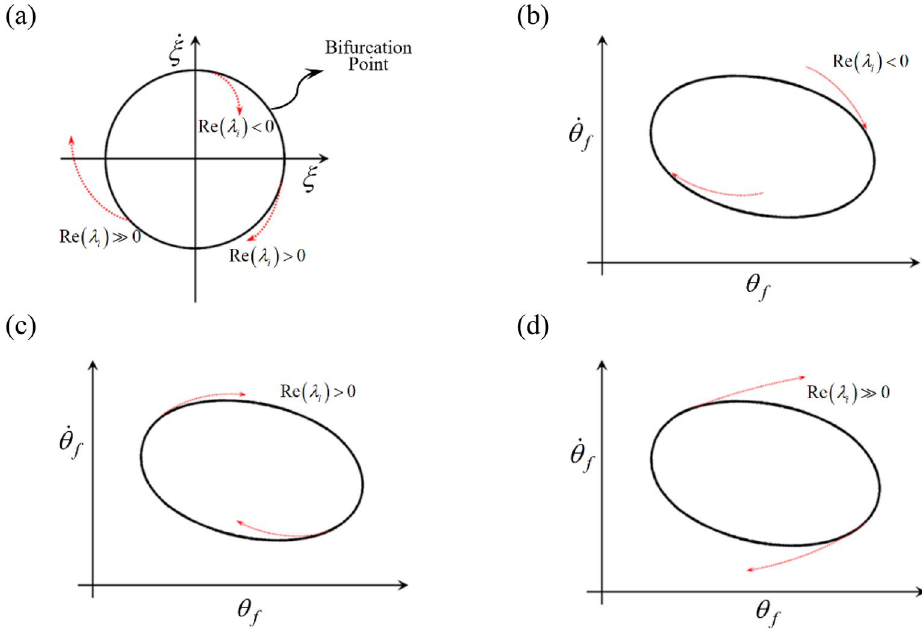
Figure 8. Nonlinear dynamic behaviors along with the various real parts of eigenvalues: ( a ) bifurcation points and various branches of transient responses; ( b ) system response under Re ( (cid:31) i ) < 0 ; ( c ) system response under 0 ; ( d ) system response under Re ( (cid:31) Re ( (cid:31) ≫ 0 . i ) > i )